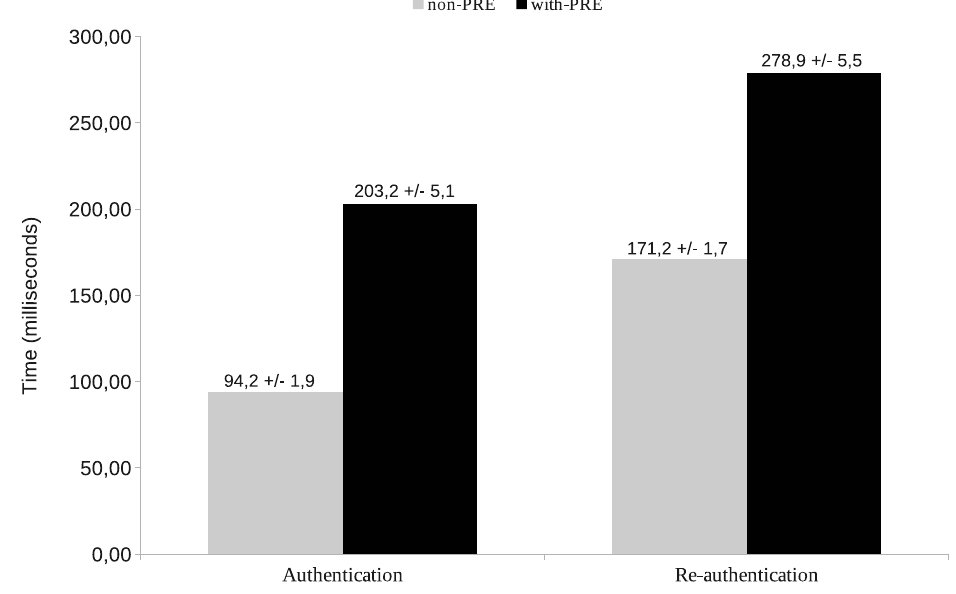
Figure 8. Mean message processing time (Note that in both cases, authentication and re-authentication, time(non-PRE) = messages processing time in PaC. Thus, time (with-PRE) = time(non-PRE) + messages processing time in